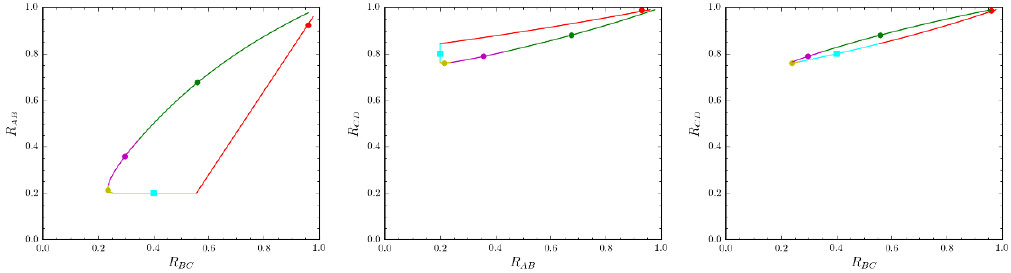
Figure 15 . The same as (cid:12)gure 3, but for the (cid:13)at direction generated by point P